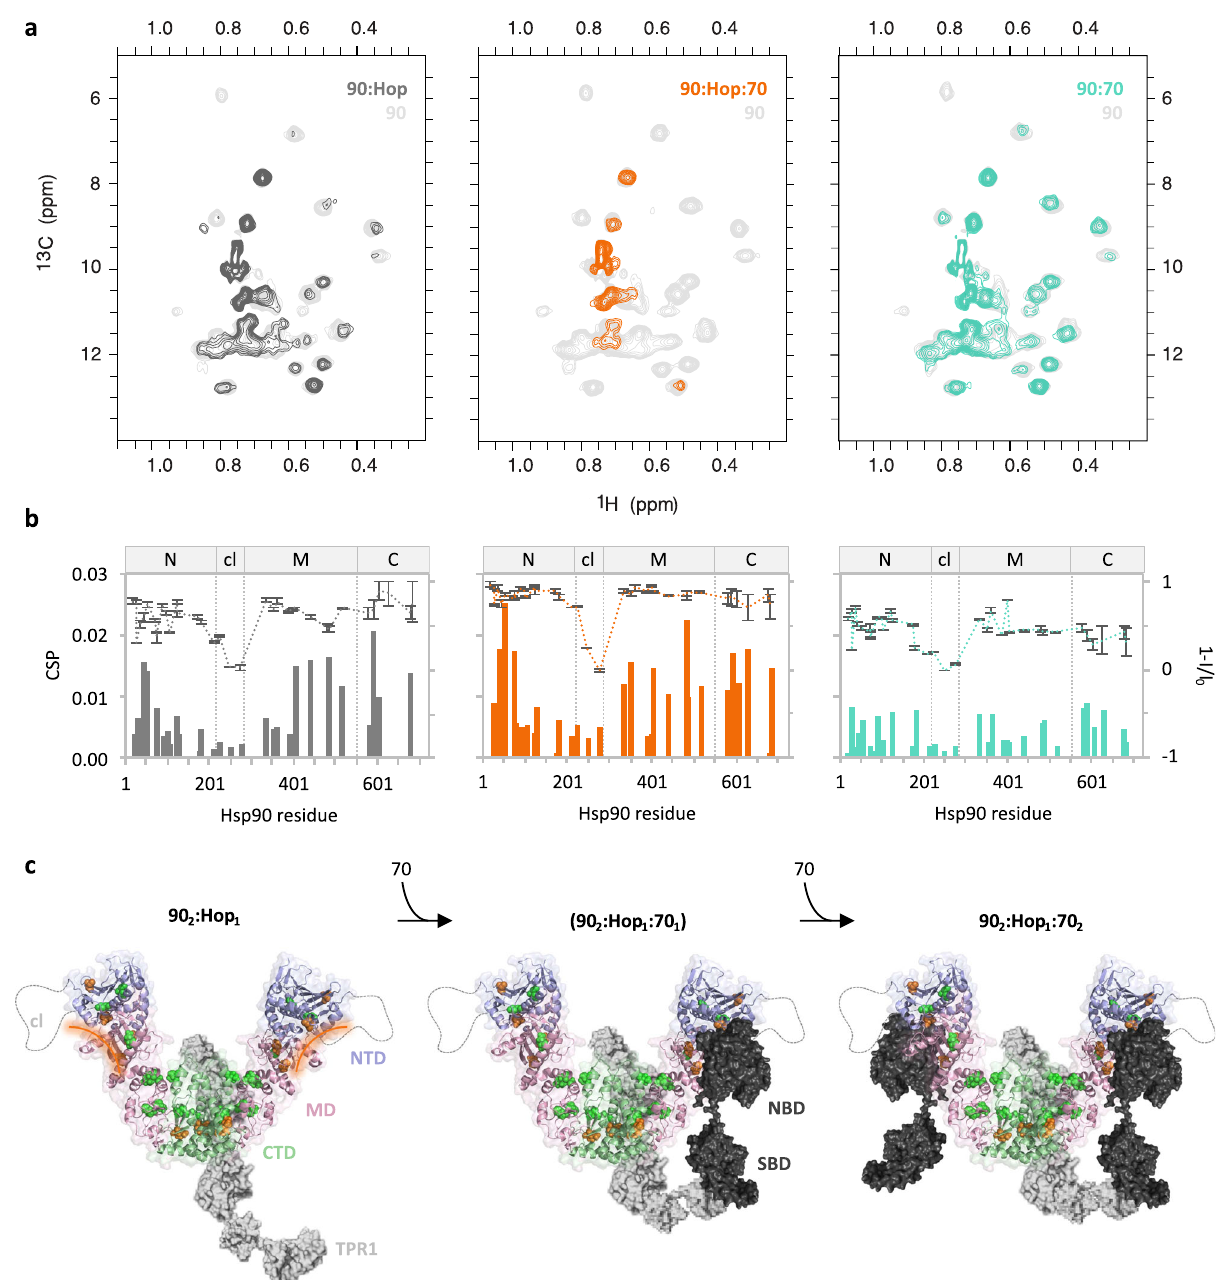
Fig. 3 Formation of the Hsp70/Hsp90 multichaperone complex followed by NMR. a 2D 13 C- 1 H methyl-TROSY spectra of Hsp90 alone (light gray) and in the presence of Hop and Hsp70 (orange). Spectra of Hsp90 with Hop only (dark gray) 25 and Hsp70 only (turquoise) are shown for comparison. b Chemical shift perturbation (bars) and peak intensity changes (dotted lines) of Hsp90 ’ s isoleucine δ -methyl groups observed in ( a same color code). I 0 is the Hsp90 signal intensity in the unbound state (light gray spectra in a ). Error bars were calculated from the signal-to-noise ratio of each spectrum ( n = 1 independent experiment). Hsp90 domains are depicted on top of each plot. c Cartoon representation illustrating the formation of the Hsp70/Hsp90 chaperone machinery. Front view of the V-shaped Hsp90:Hop complex is shown (Hsp90 domains: N-terminal domain NTD – purple, charged linker cl – gray, middle domain MD – pink, C-terminal domain CTD – green; Hop is depicted in gray). Affected isoleucines in Hsp90 are displayed with spheres and colored in green and orange for the Hsp90:Hop and Hsp90:Hop:Hsp70 interaction. The potential binding site of Hsp70 in Hsp90 ’ s NTD and MD is highlighted with an orange line. One Hsp70 molecule is bound via its SBD to Hop ’ s TPR1 domain 27 – the second Hsp70 molecule may bind the Hop- induced V-shape conformation of Hsp90 25,65 independent of Hop. Hsp70 is represented in black. NBD and SBD are Hsp70 ’ s nucleotide- and substrate- binding domain, respectively. Source data are provided as a source data fi